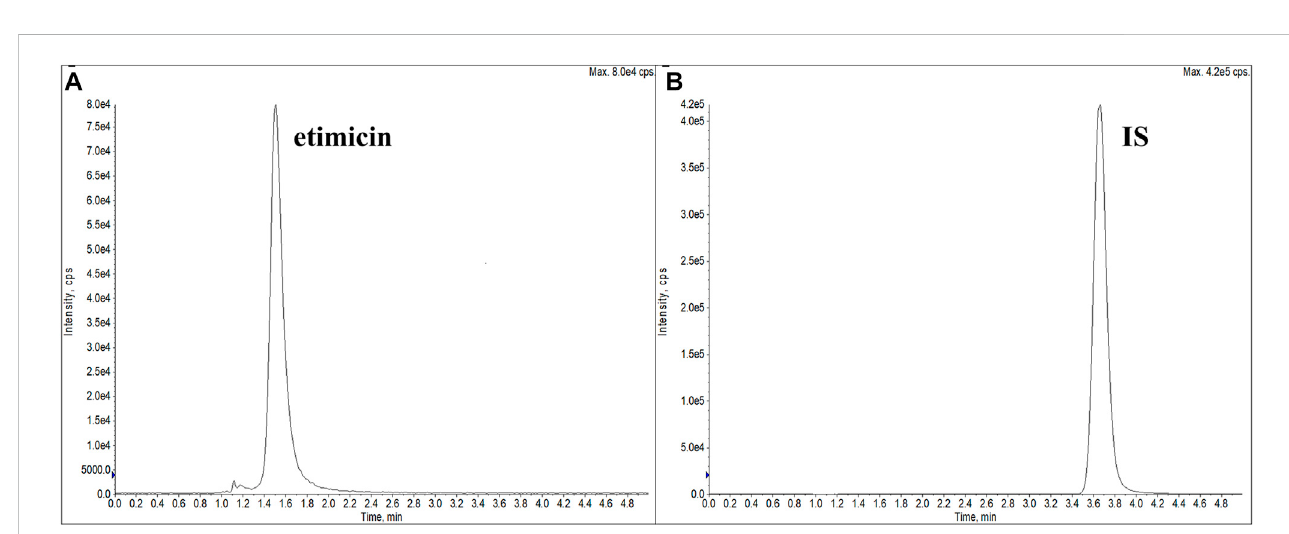
FIGURE 2 Typical extracted ion chromatograms of etimicin (A) and the IS (B) (retention time: etimicin = 1.5 min, IS = 3.7